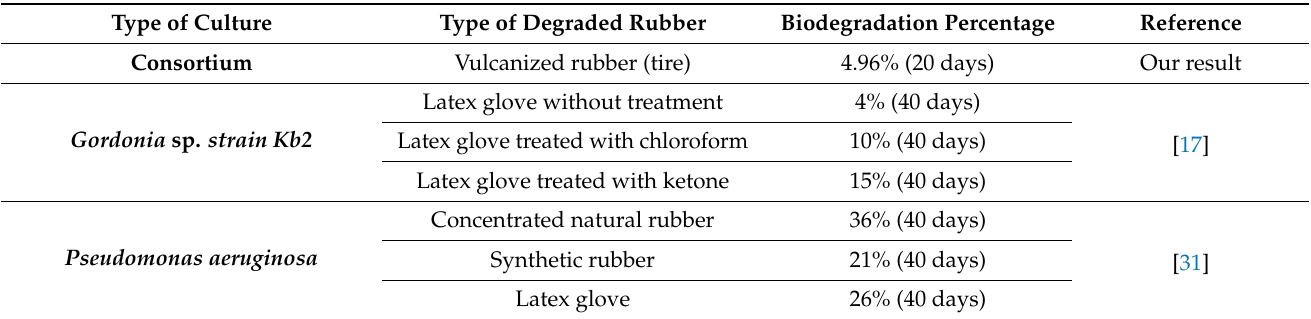
Table 2. Comparison of the degradation